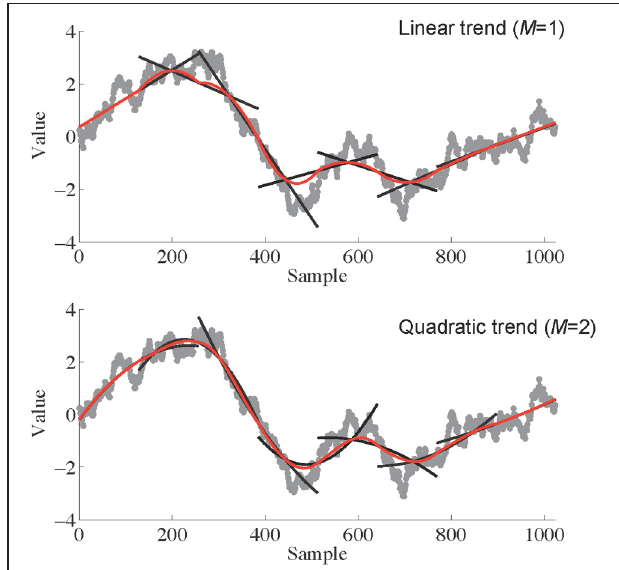
FIGURE 2 | An illustration of the process of identifying a globally smooth trend signal. Linear ( Top ; M = 1) or polynomial ( Bottom ; M = 2) trends are fit to pieces of the signal of length w (257 in this case). These fits are shown as black lines superimposed on the original data series (gray curves). The local fits are then stitched together (see Equation 1) to create a smooth global trend signal, depicted in red. Notice that when the end of the series is encountered only half of the data points in that window are used for the trend without